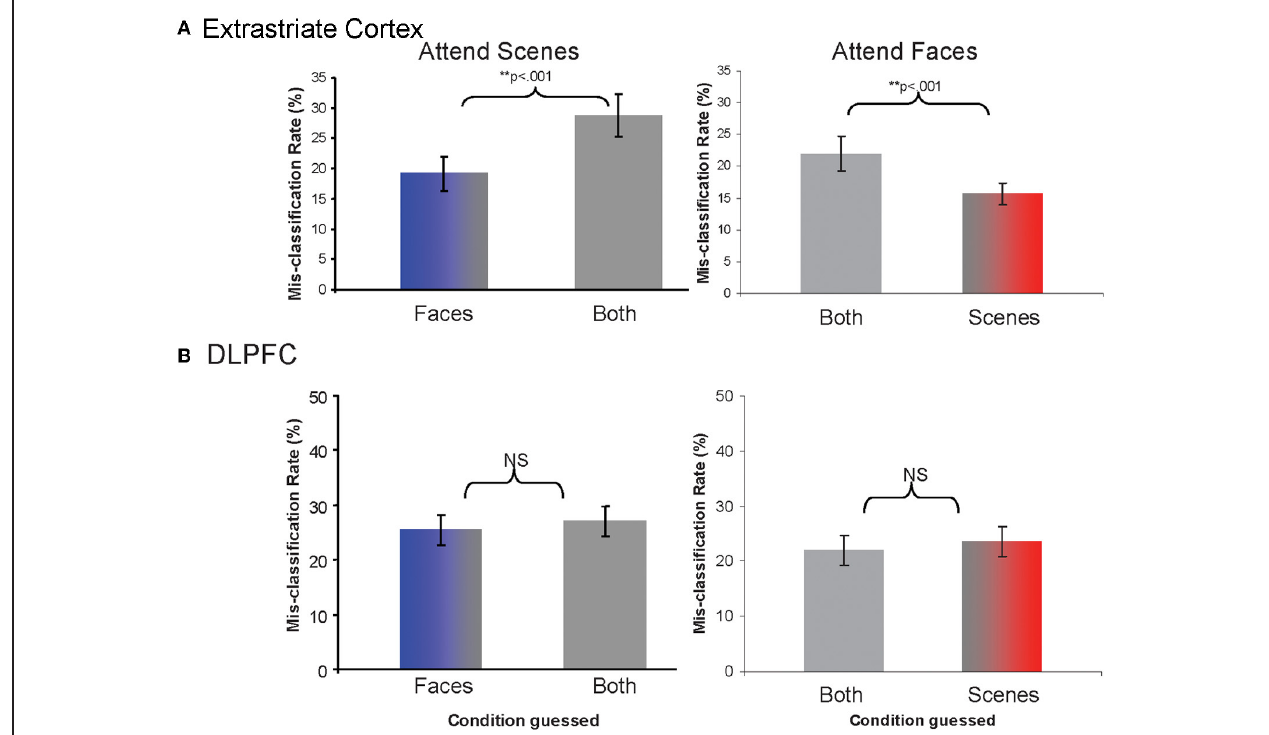
FIGURE 4 | Rates of mis-classification as each of the alternative conditions when the pattern samples are derived from Attend Scenes or Attend Faces trials, for (A) extrastriate cortex and (B) DLPFC.